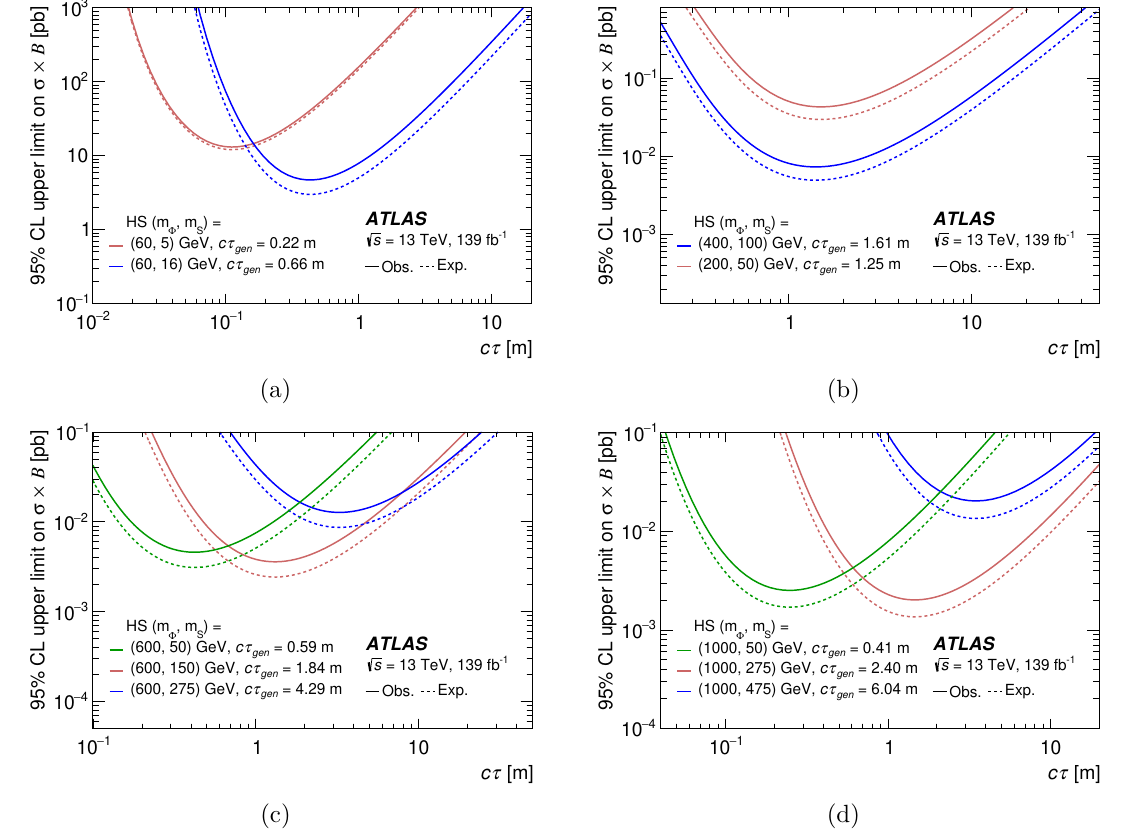
Figure 11. Summary of 95% CL expected and observed limits for the hidden sector (HS) models considered in this analysis, where the mediator is not the SM Higgs boson: (a) shows the case where m Φ = 60 GeV ; (b) shows intermediate masses of m Φ = 200 GeV and m Φ = 400 GeV ; (c) shows the case where m Φ = 600 GeV ; (d) shows the highest m Φ hypothesis with m Φ = 1 TeV